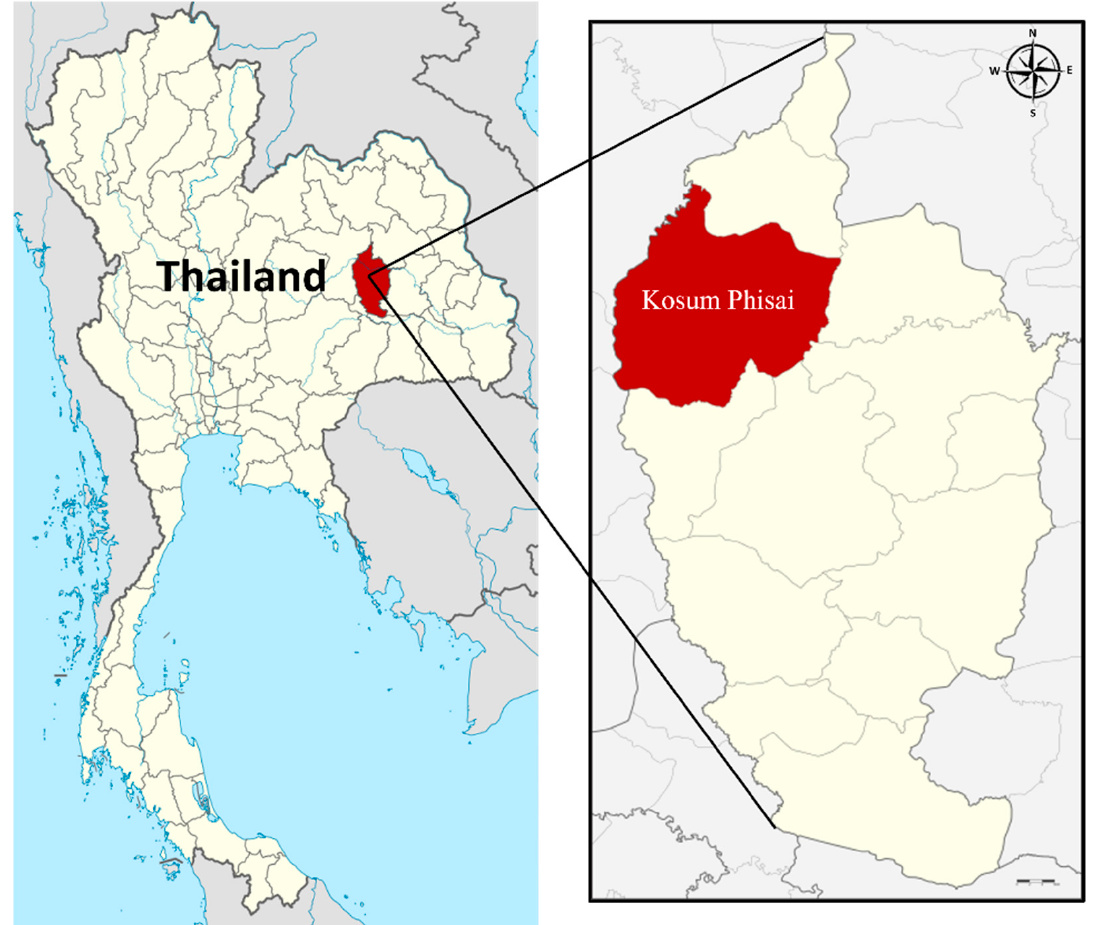
Figure 1. Map shows Kosum Phisai district, Maha Sarakham in the northeast of Thailand, where the Kosumpee Forest Park is located. (Source: https://en.wikipedia.org/wiki/Maha_Sarakham_prov- ince, accessed on 18 September 2022).